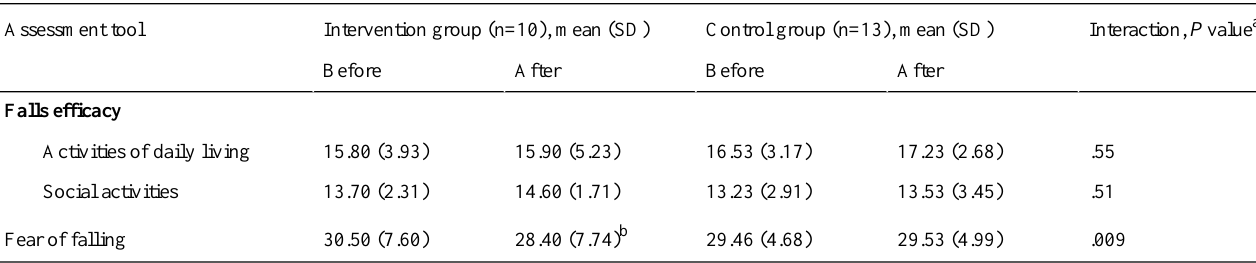
a The interaction effect between time and group was evaluated in terms of the P value obtained using two-way repeated-measures analysis of variance. b P <.001. c P <.05. Values indicate a significant difference between pre- and posttest measurements (ie, Before vs After for the same group). Table 4. Changes in psychological risk factors for falling. Before and After refer to measurements taken before and after the 12-week intervention period, respectively.